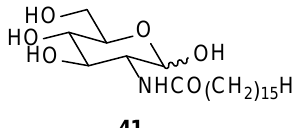
Figure 31. N -palmitoylglucosamine.